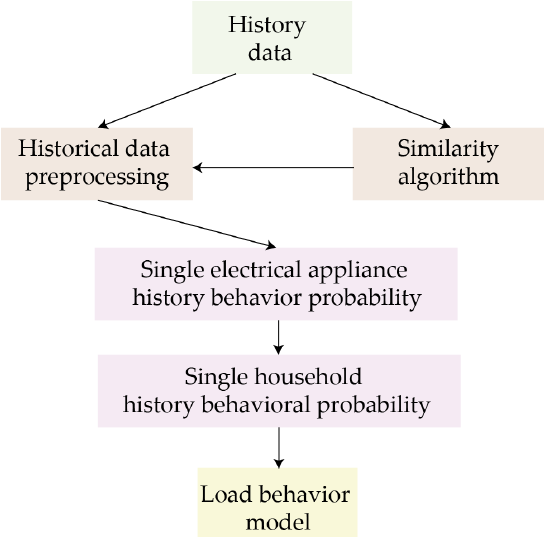
Figure 1. Framework for forecasting the energy consumption of a household appliance (after Ref. [20]).